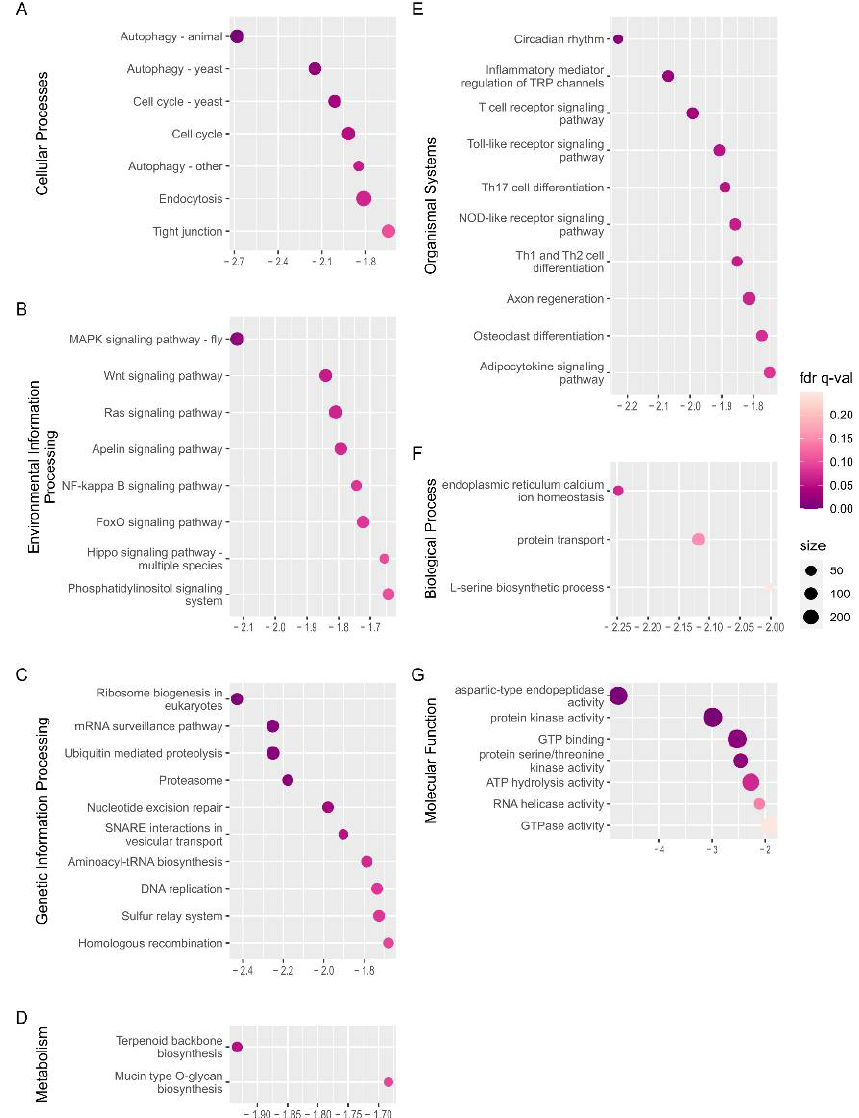
Figure 6. GSEA analysis of WSG1 versus WSG4. ( A – E ) Significantly negatively enriched gene set of the top KEGG orthology pathway categories; the y -axis shows the definition of the gene set from the KEGG pathway. ( F , G ) Significantly negatively enriched gene set of GO annotation from the major domains; the y -axis shows the GO terms of the enriched gene set. The NES is indicated on the x -axis in ( A – G ). A negative sign in NES demonstrates that gene sets were activated in state of WSG1. The circle size represents the number of genes from each enriched gene set. 2.6. Verification of RNA Sequencing Data by Quantitative Polymerase Chain Reaction (qPCR) The credibility of the RNA sequencing data was confirmed by qPCR. Six genes were selected from the DEGs and their relative expression levels were determined. Four genes were downregulated compared with WSG1 (evm.TU.scaffold97.len2227468.20, evm.TU.scaffold51.len2996135.22, evm.TU.scaffold34.len3691886.43, evm.TU.scaffold69.len2603645.54),